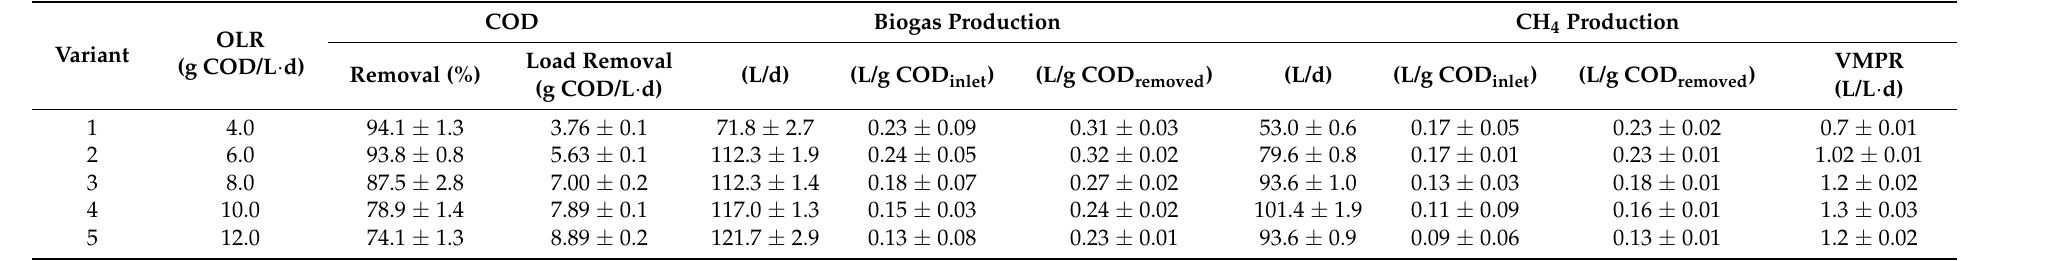
Table 4. Removal of organic compounds and production of biogas and CH 4 in stage